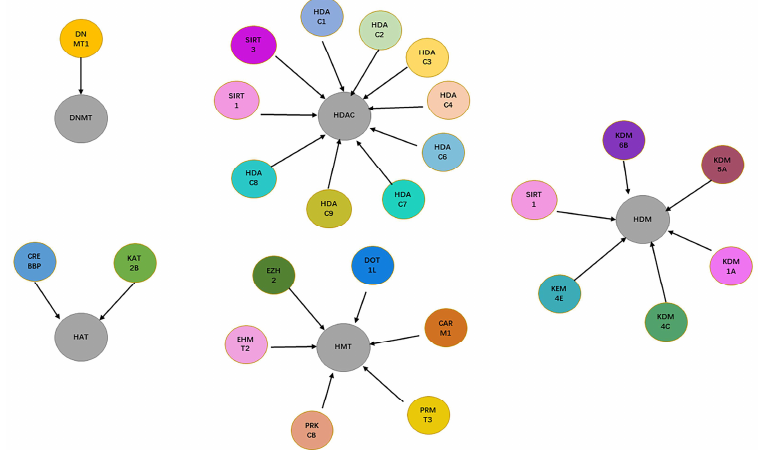
Figure 2. Overview of the target proteins related to epigenetic objects: DNMT, HMT, HAT, HDM, and HDAC.